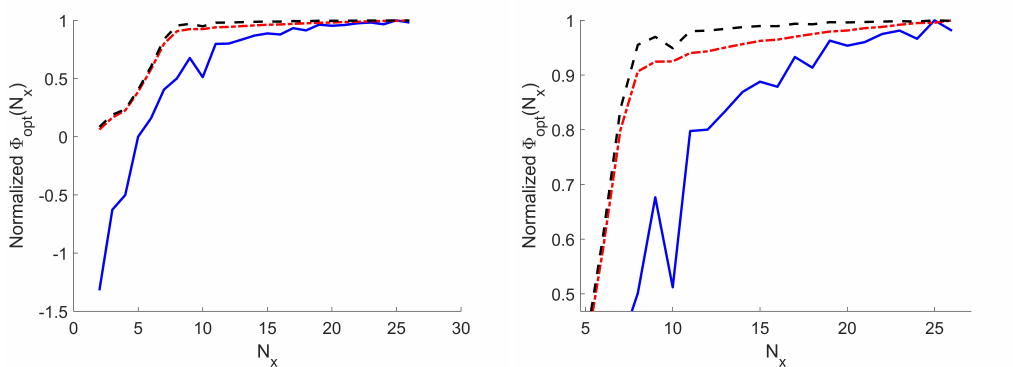
( i ) ( N x ) curves—The Φ ( 1 ) ( N x ) curve is reported in a log scale—all curves are normalized to their Figure 3. Case A. Φ opt opt respective maxima. Blue solid line: Shannon number. Black dashed line: Mutual information. Red dash-dotted line: Fisher information. ( Left ) full curves. ( Right ) zoom around the